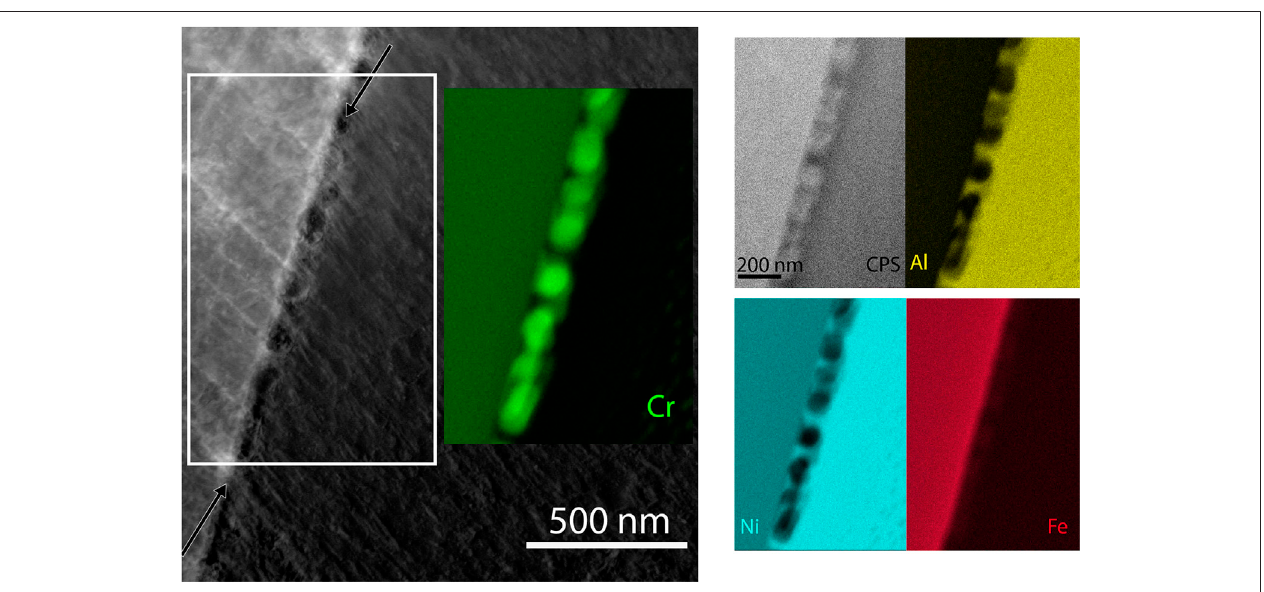
FIGURE 6 | Scanning transmission electron microscopy image in high-angle annular dark- fi eld mode and transmission electron microscopy-energy dispersive spectroscopy map of a characteristic interface region between the FCC and BCC-B2 lamellae of a sample of the directionally solidi fi ed Ni 44 Fe 20 Cr 20 Al 16 alloy.